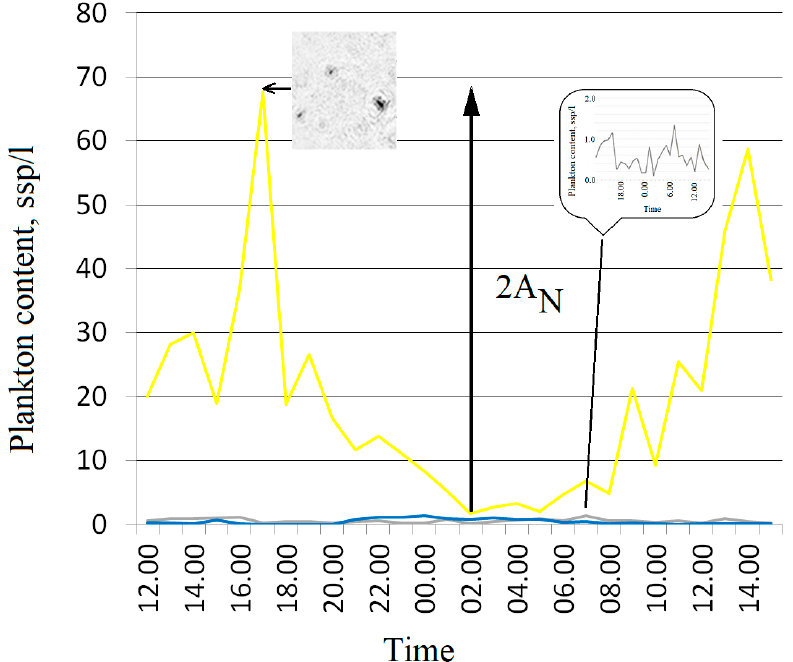
Figure 5. Daily changes in the composition of coastal plankton of Lake Baikal according to the net technology data. Yellow line—epischura (COPEPODA taxon), mainly of the naupliar stage; gray— rotifers (ROTIFERA taxon); blue—bottom copepods, Harpacticoida order in a water column (5-0 m). A N —amplitude of epischura abundance fluctuations in 1 L of water per day, 3 September 2021.